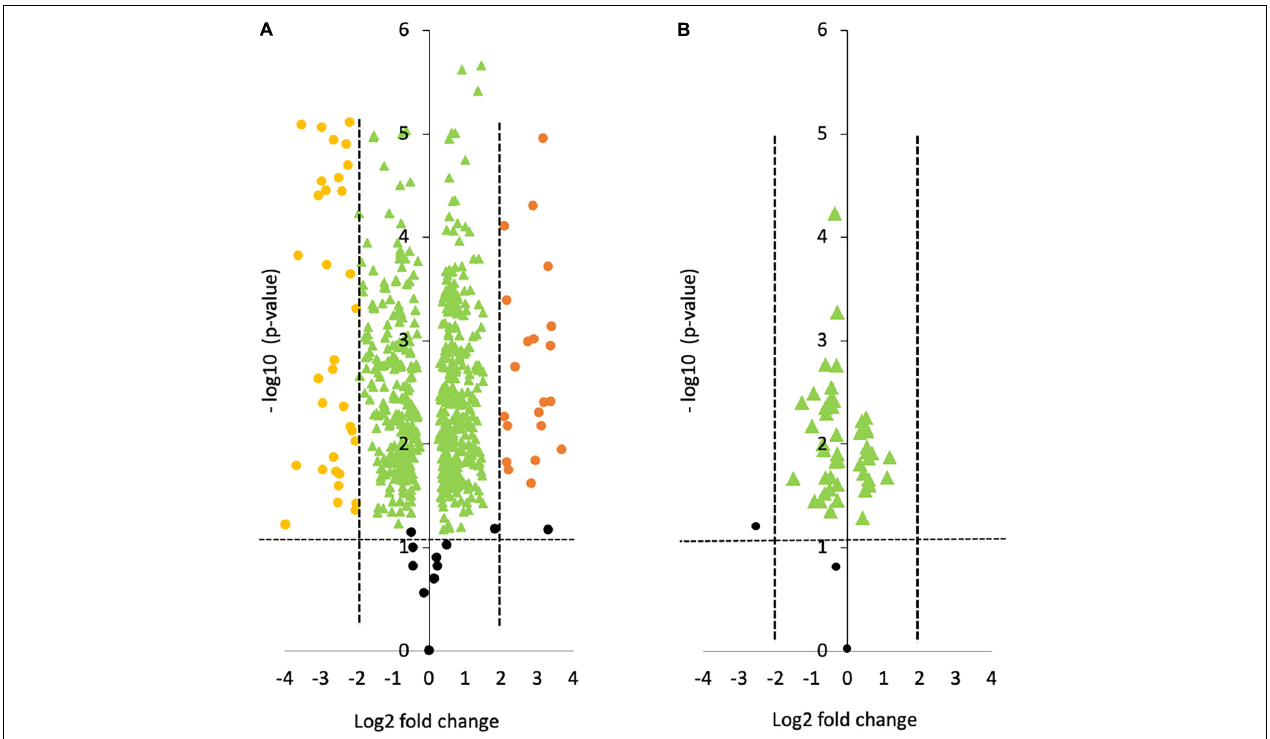
FIGURE 2 | Volcano plots representing the pairwise comparison of (A) Oval vs. Fusiform (OF); (B) Triradiate vs. Fusiform (TF). The volcano plots show a change in protein expression ( t -test p -value) between (A) oval and fusiform cells, (B) triradiate and fusiform cells. Fusiform cells are considered as the reference. Orange and yellow dots represent up-regulated and down-regulated proteins at a log fold change upper or lower than 2, respectively ( p -value ≤ 0.05). Green dots represent protein that has a fold change comprised between –2 and 2. Black dots represent the non-differentially expressed